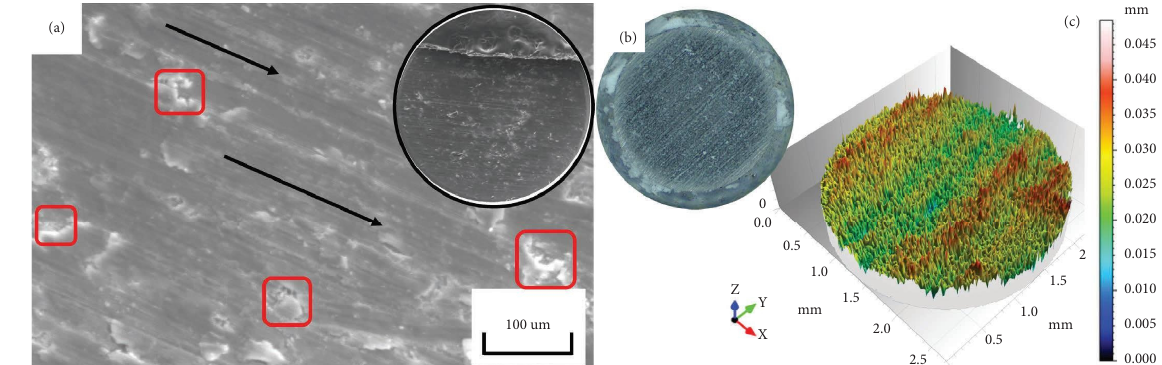
Figure 5: SEM image, optical microscopy, and 3D surface topographies of wear track of glass